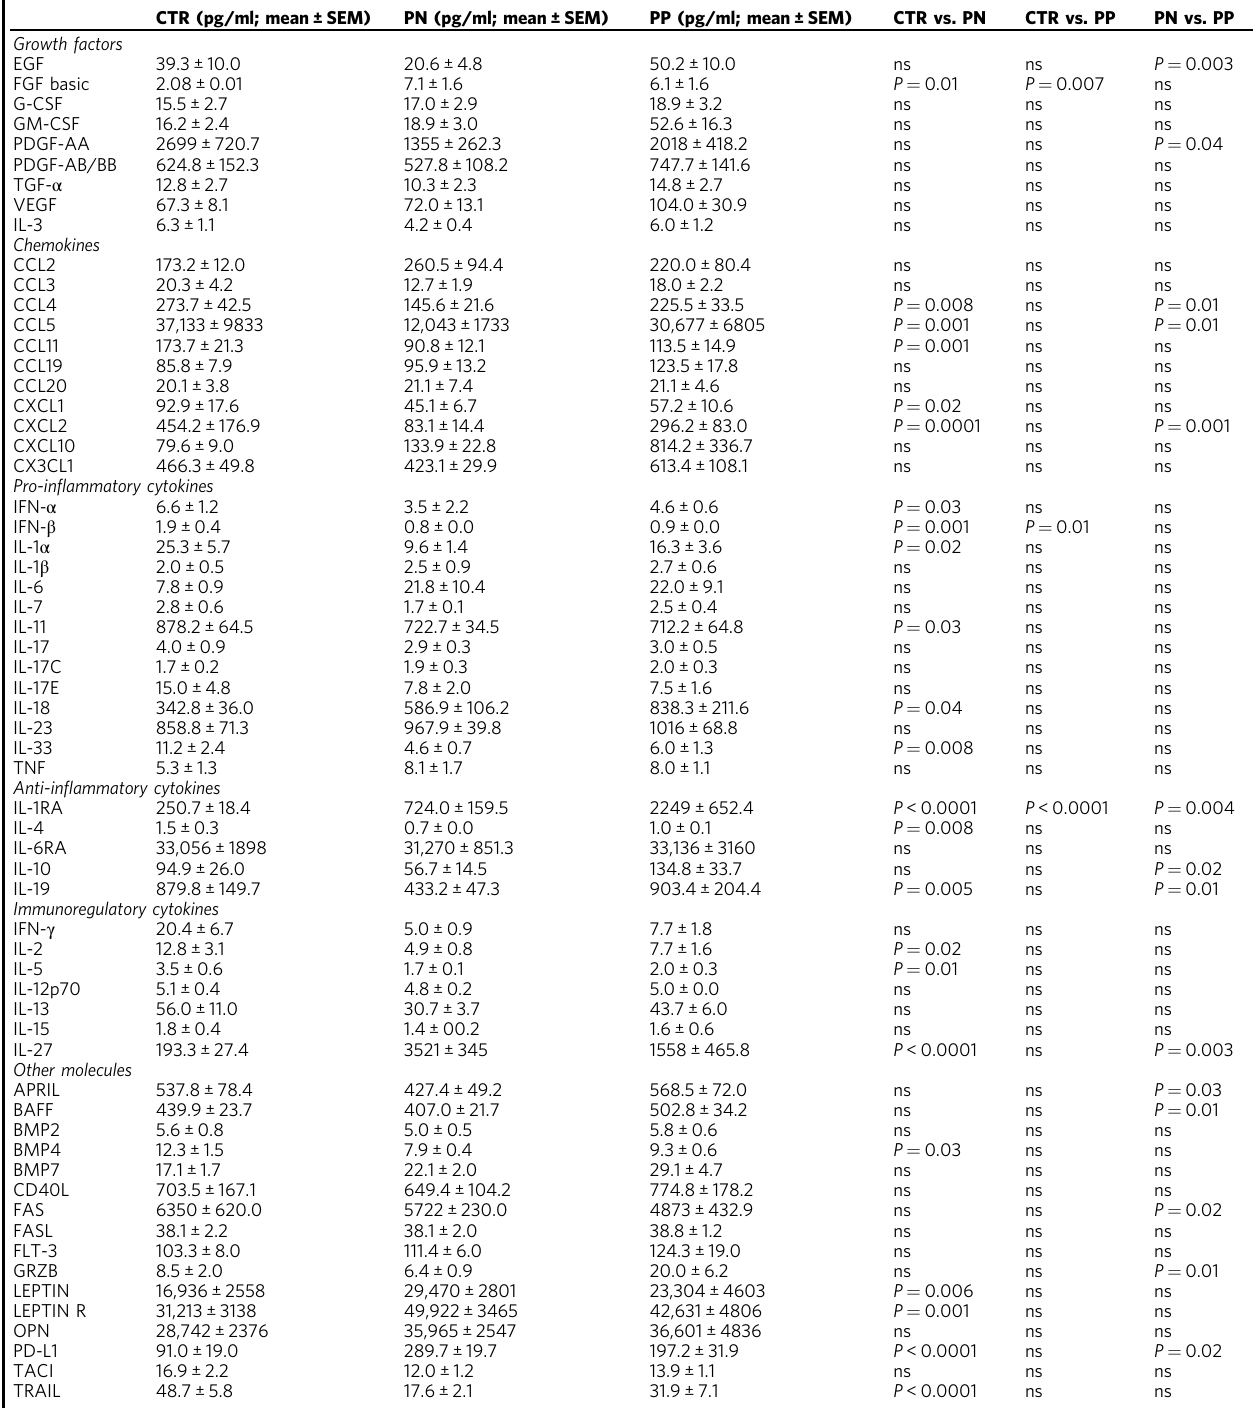
Table 1 Plasma levels of 62 cytokines measured in 14 infected pregnant women (PP), 28 uninfected pregnant women (PN) and 15 age-matched nonpregnant controls